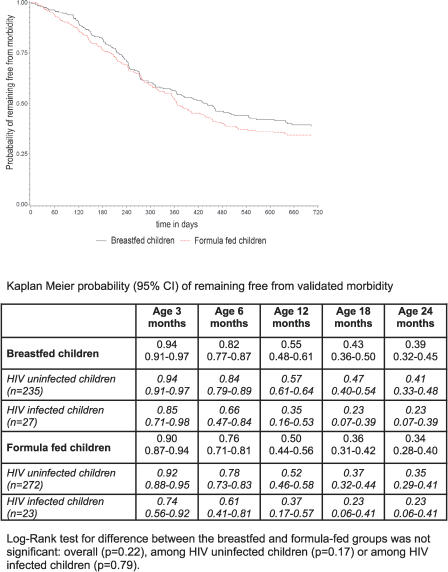
Two-Year Probability of Remaining Free from Validated Morbidity (Diarrhea, Acute Respiratory Infection, or Malnutrition) According to the Feeding Group and Pediatric HIV StatusANRS 1201/1202 Ditrame Plus Study, Abidjan, Côte d'Ivoire, 2001–2005 (n = 557).